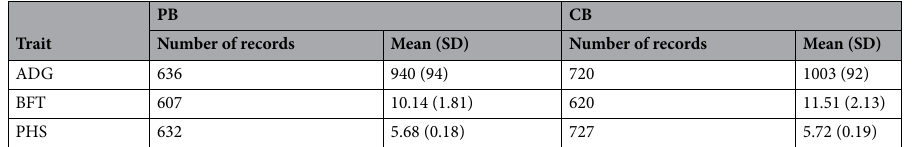
Table 1. Summary statistics of the purebred (PB) and crossbred (CB) phenotype data. ADG average daily gain (g/day), BFT backfat thickness (mm), PHS pH of the semimembranosus muscle (pH